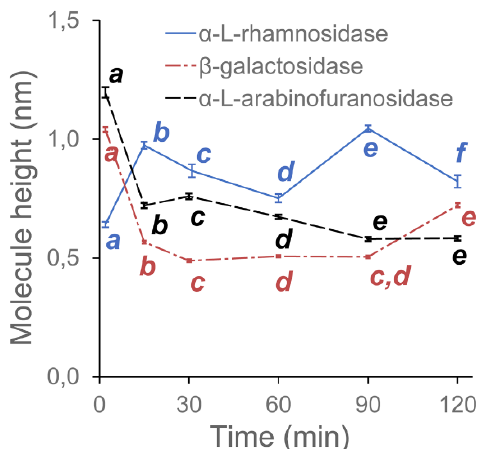
Figure 6. Changes in the diameter of DASP molecules with respect to the duration of enzyme treatment. Different letters indicate significant differences (according to ANOVA with p = 0.05). Bars indicate 95% confidence intervals for mean values. The diameter was defined as the maximum height value measured at the central line of the molecule (skeleton).